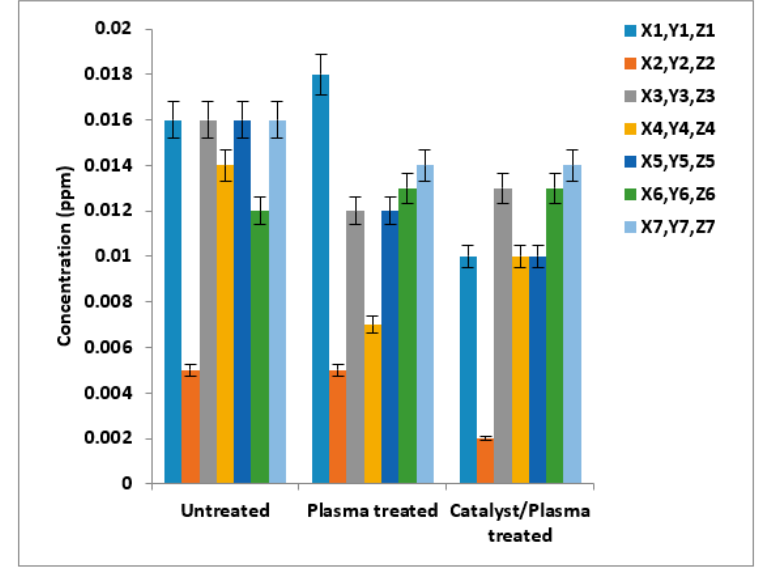
Figure 4. Cr concentration in untreated and plasma-treated water samples.